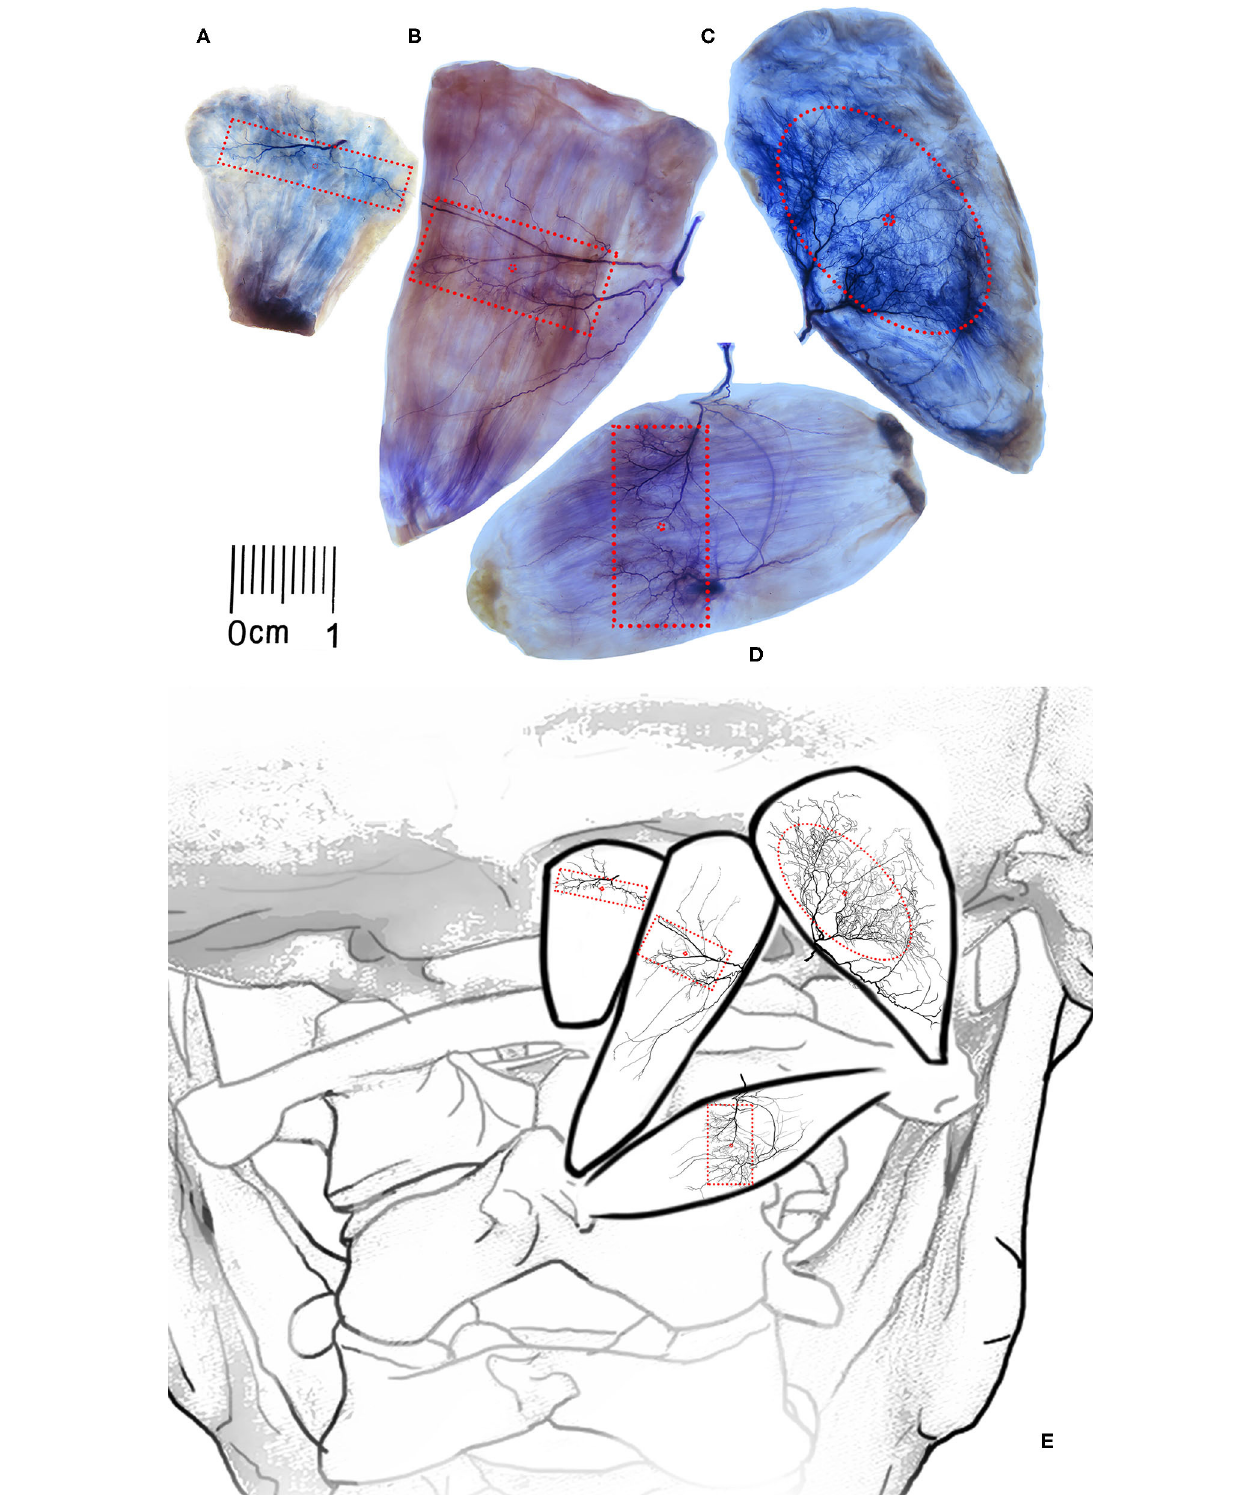
FIGURE 2 | Overall distribution pattern of intramuscular nerves and position of nerve-dense region of the suboccipital muscle. (A–D) Showing the Sihler’s staining of the rectus capitis posterior minor muscle, rectus capitis posterior major muscle, obliquus capitis superior, and obliquus capitis inferior muscles, respectively. The red boxes showing the intramuscular nerve dense regions, and the red points represent the center of the intramuscular nerve dense regions. Scale: cm. (E) A schematic drawing showing the intramuscular position of INDRs and CINDRs.